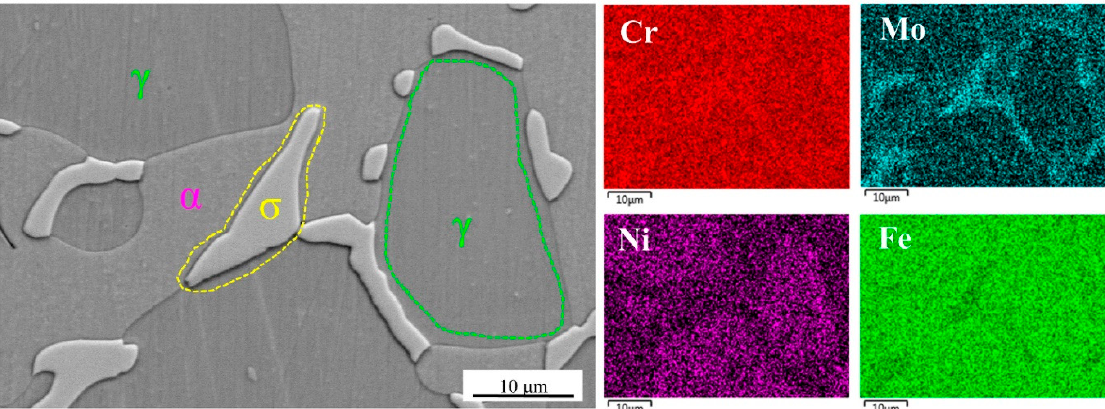
Figure 3. SEM image and EDS elemental distribution assessment of the function of Cr, Mo, Ni, and Fe of each specimen after solution treatment at 1040 °C.